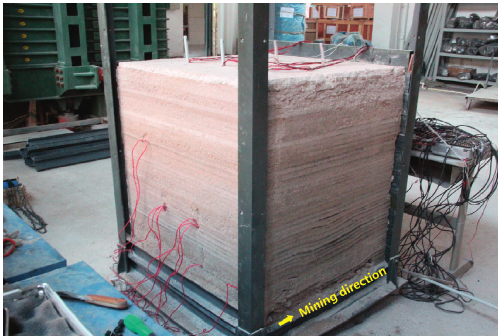
Figure 9: The three-dimensional model with the steel plates removed.